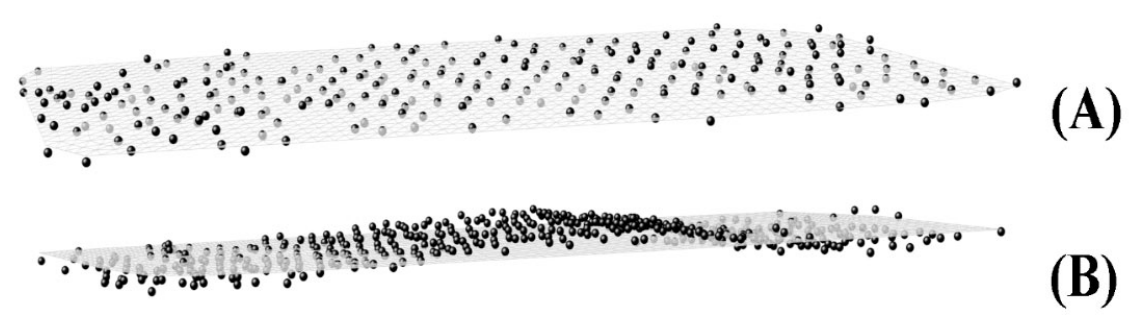
Figure 4. Fitted plane to the middle ( C 8 ) atoms in a crystallite of HEX/Surf/water simulated at 289 K ( A ) without a defect and ( B ) with a defect.